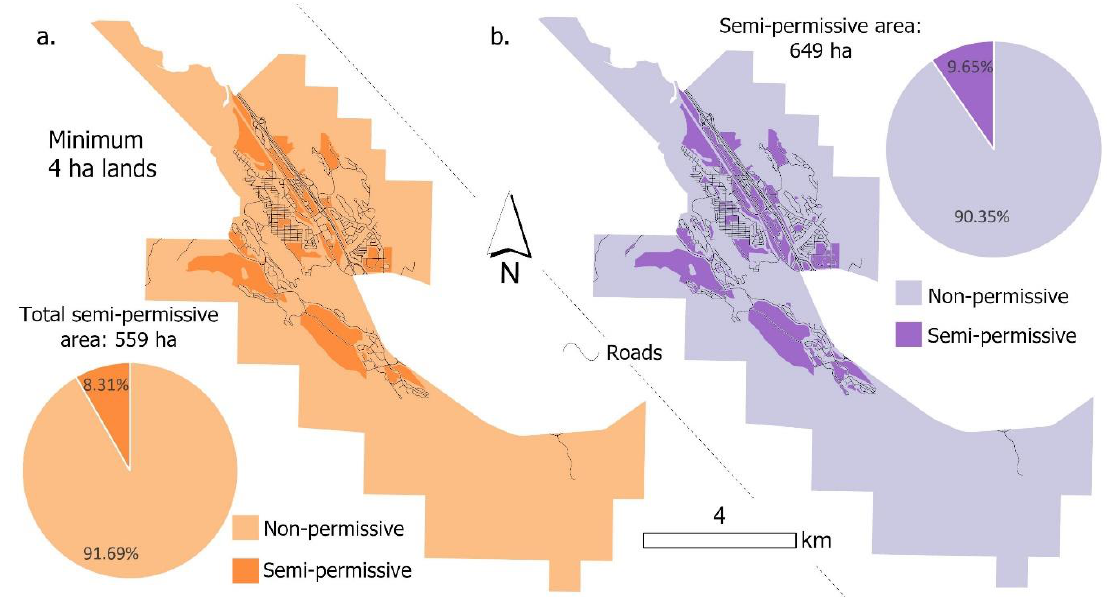
Figure 5. Legally accessible resources for solar ( a ) and wind ( b ) energies mostly based on land use bylaw (LUB).